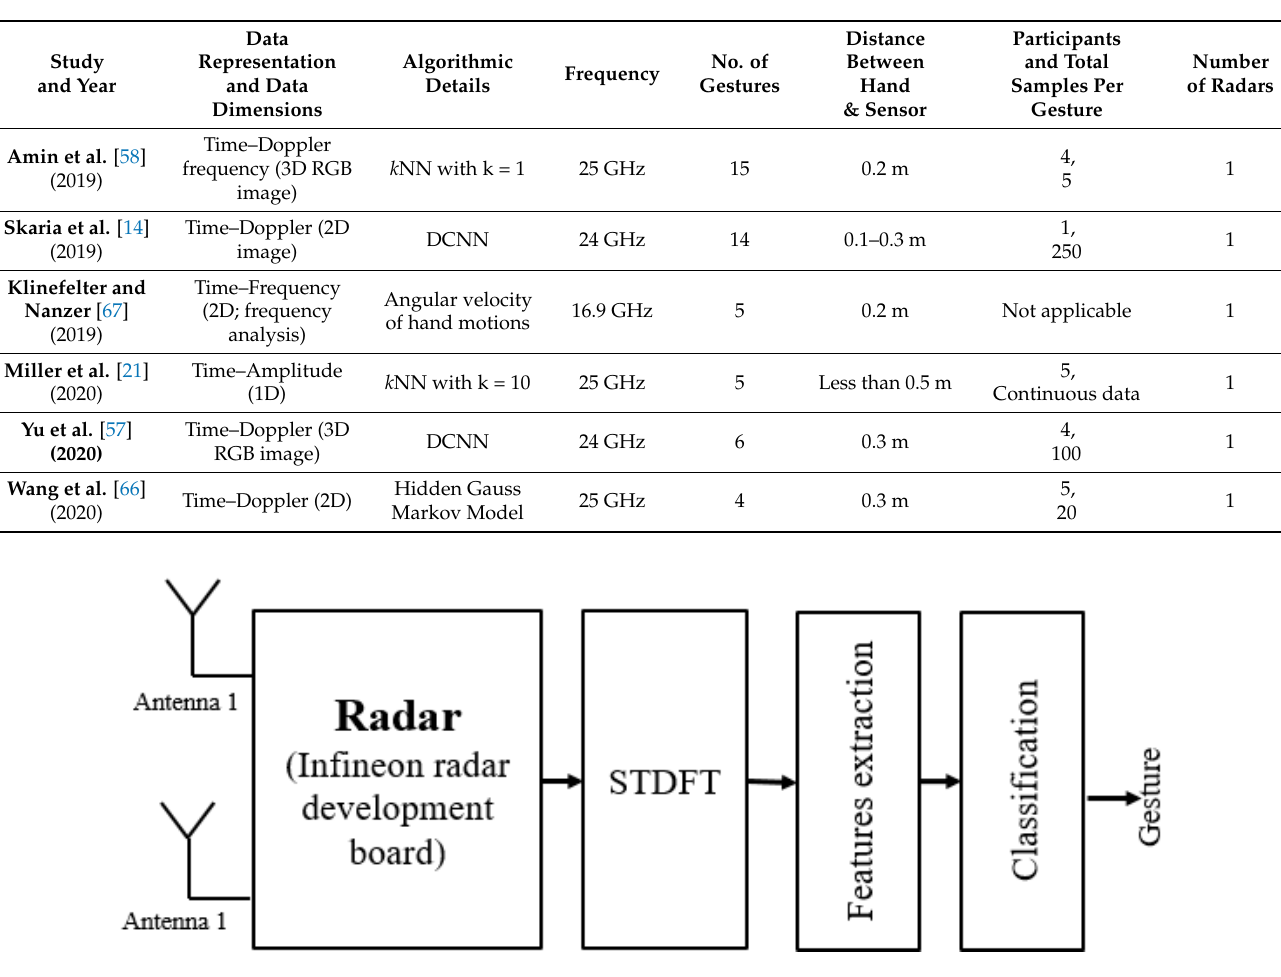
Figure 9. Two antenna Doppler radar assembly and DCNN architectures for HGR [14].